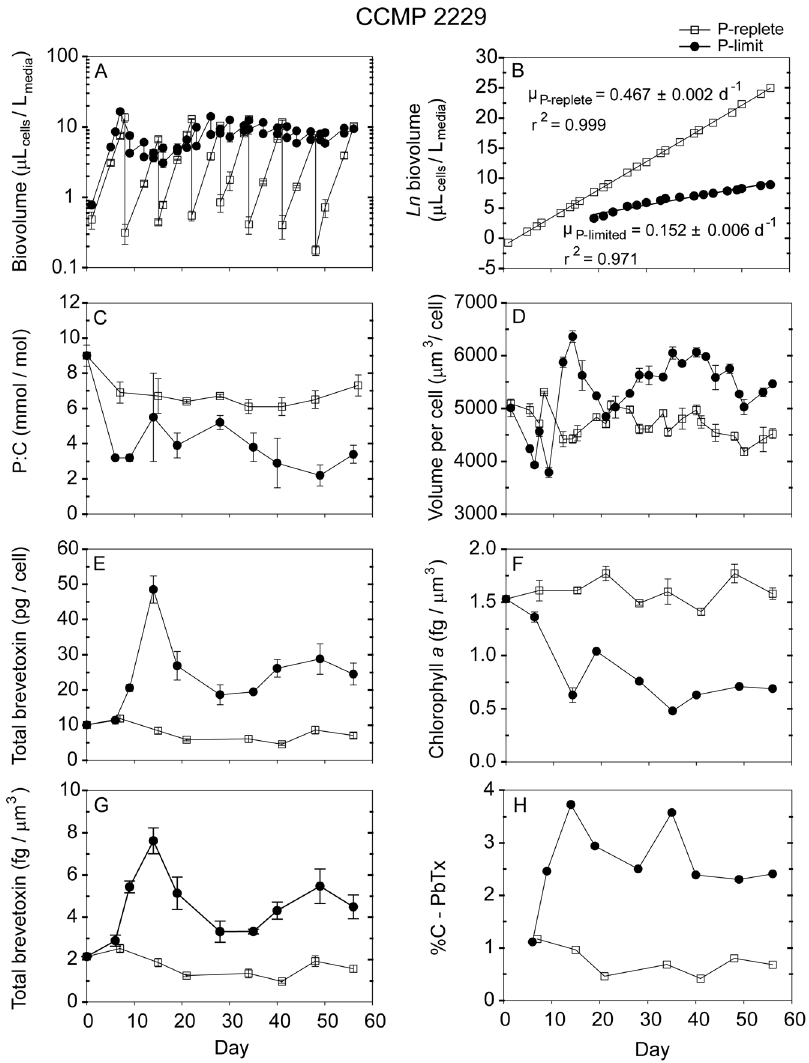
Figure 5. Time dependent results from semi-continuous batch cultures a Kareniabrevis strain CCMP 2229 grown at nutrient-replete rates in high-P media (open squares) and grown into P-limitation in low-P media (filled circles). Biovolume ( m L cells /L media ) plotted on a log scale vs. time, (B) Natural logarithm (ln) biovolume vs. time, correcting for culture dilution [39], (C) Cellular P:C ratios (mmol/mol), (D) Mean volume per cell ( m m 3 /cell), (E) Total brevetoxins per cell (pg/cell), (F) Chlorophyll a normalized to cell volume (fg/ m m 3 ), (G) Total brevetoxins normalized to cell volume (fg/ m m 3 ), (H) Percent of cellular carbon associated with brevetoxins (%C-PbTx). Error bars represent the standard deviation of triplicate measurements, except those normalized to carbon, where the cellular C was measured only in duplicate.